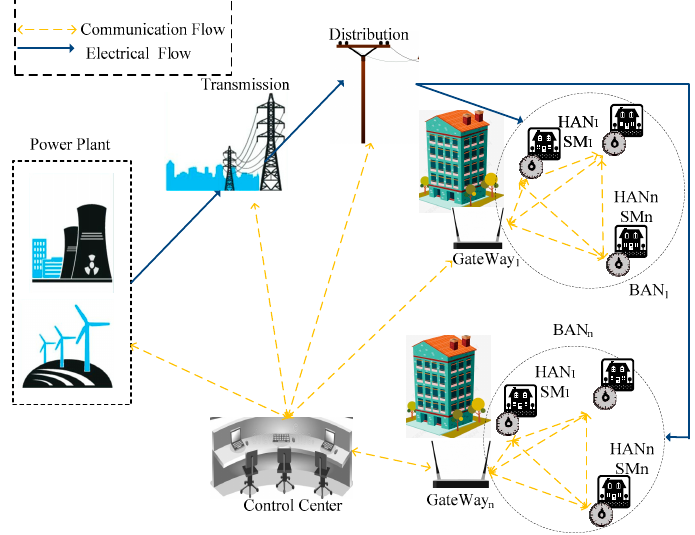
Figure 1. System model under consideration.